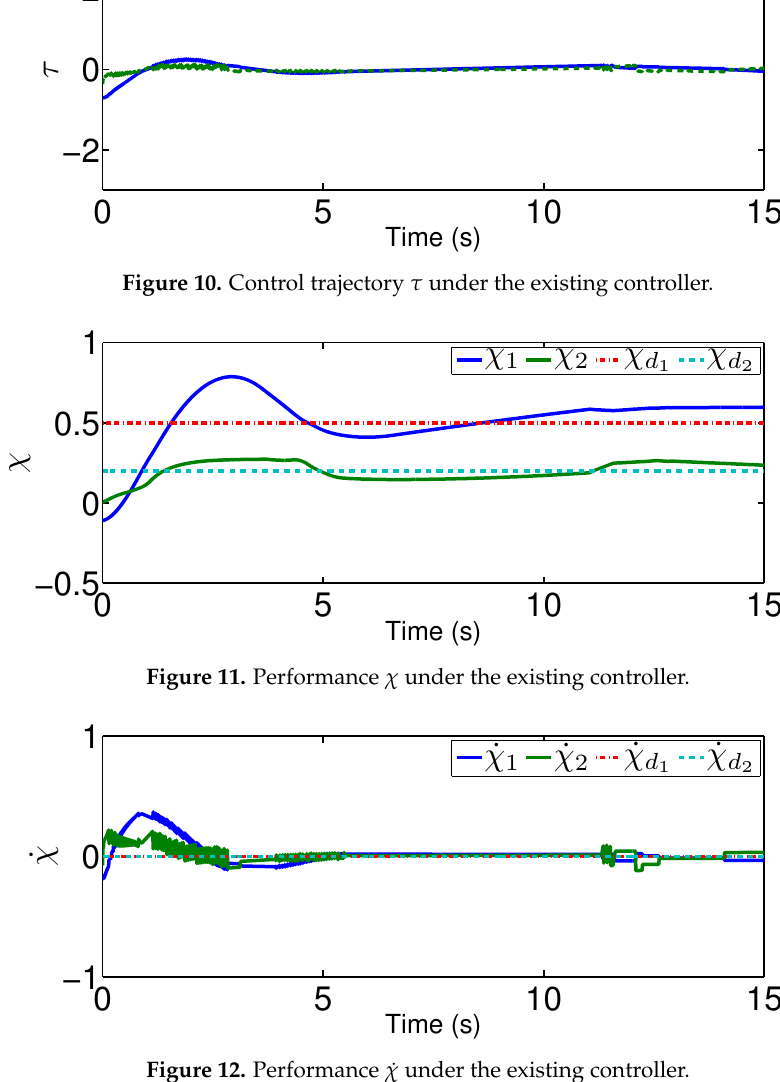
Figure 12. Performance ˙ χ under the existing